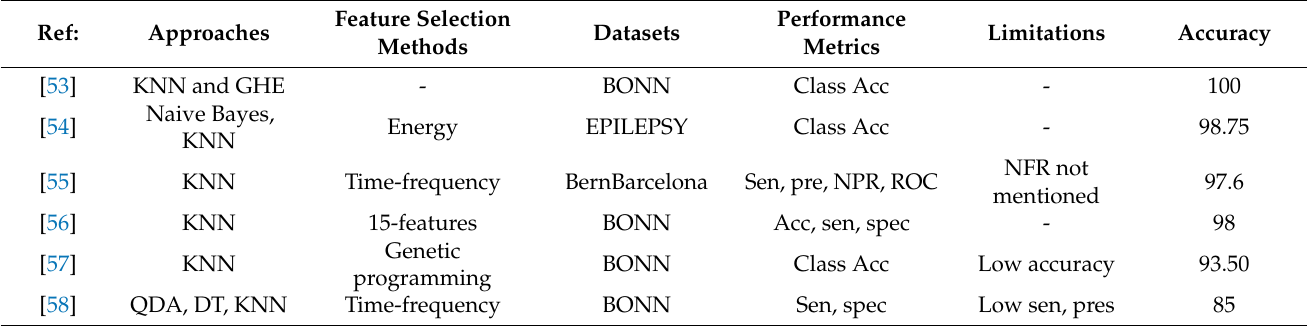
Table 7. A review on KNN approach for seizure